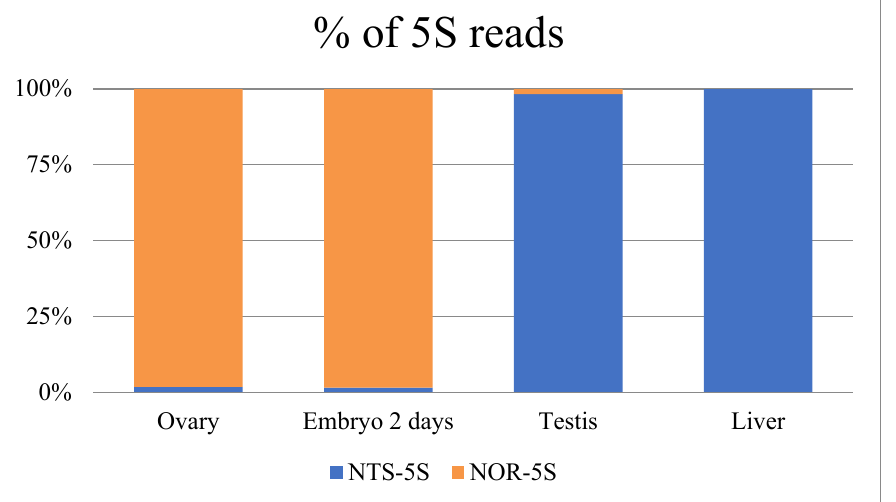
Figure 3. Different representation of the NOR-5S and NTS-5S rRNA sequencing reads in different tissue transcriptomes of Dissostichus eleginoides (Dissostichinae). Percentage of total 5S rRNA sequencing reads was calculated from NCBI BioProjects PRJNA511578 data.